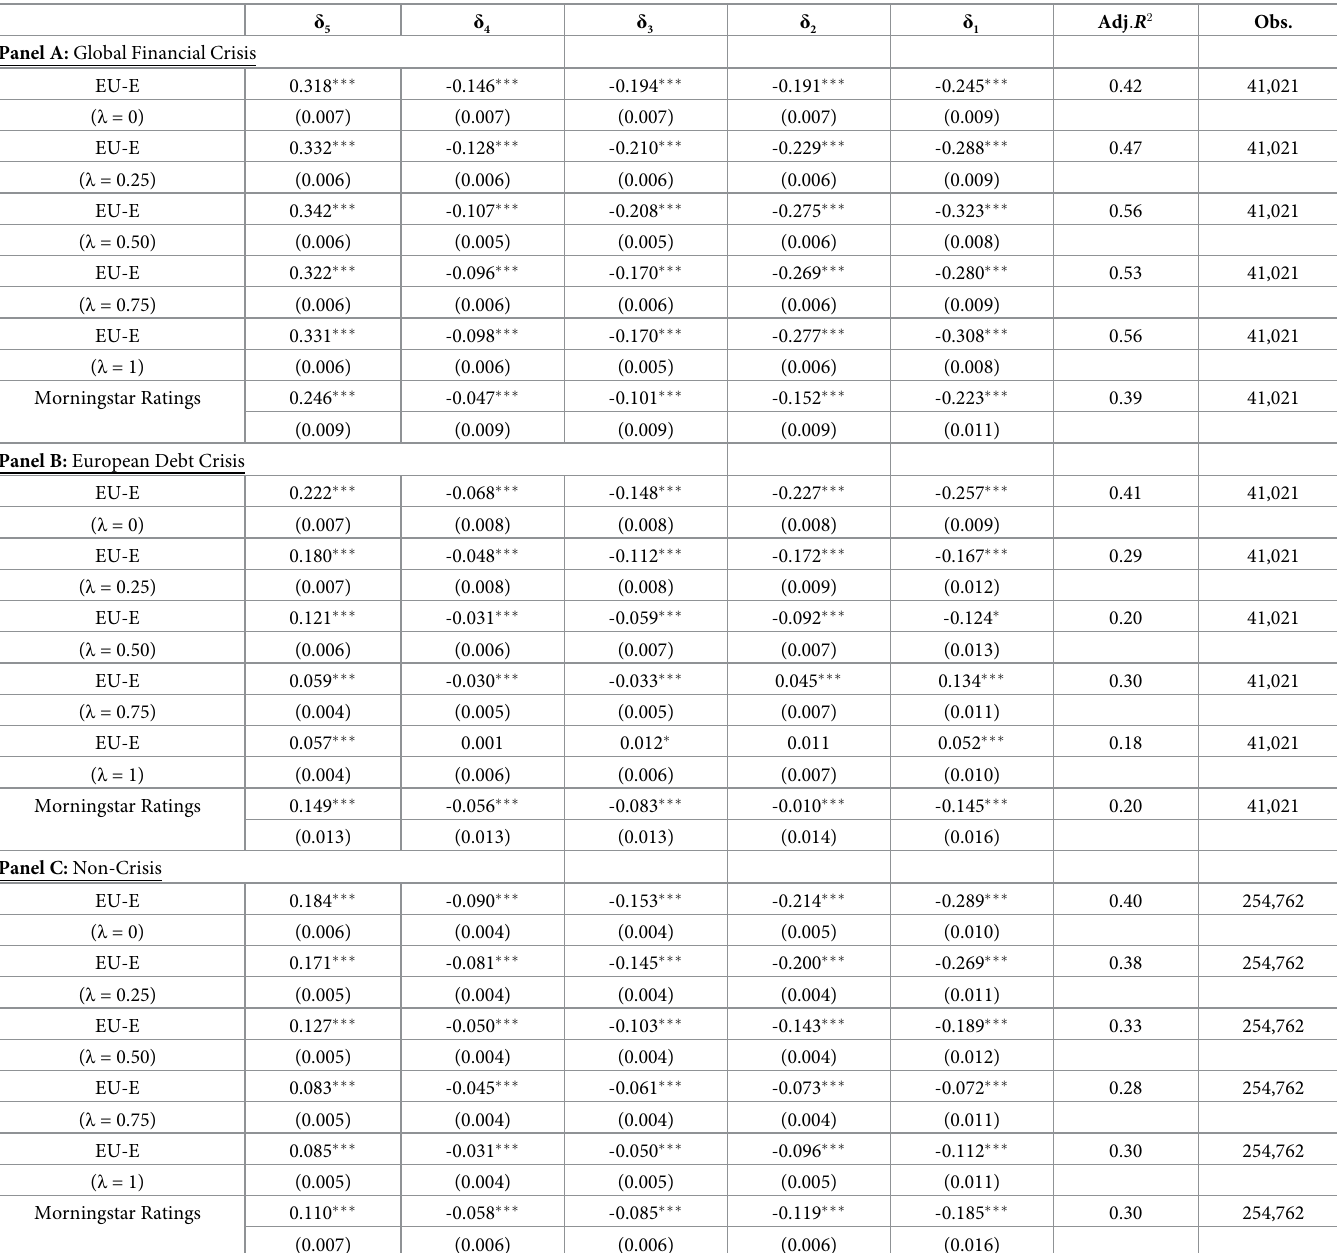
Table 7. Panel regression results across crises sub-samples where the Sharpe ratio measures out-of-sample